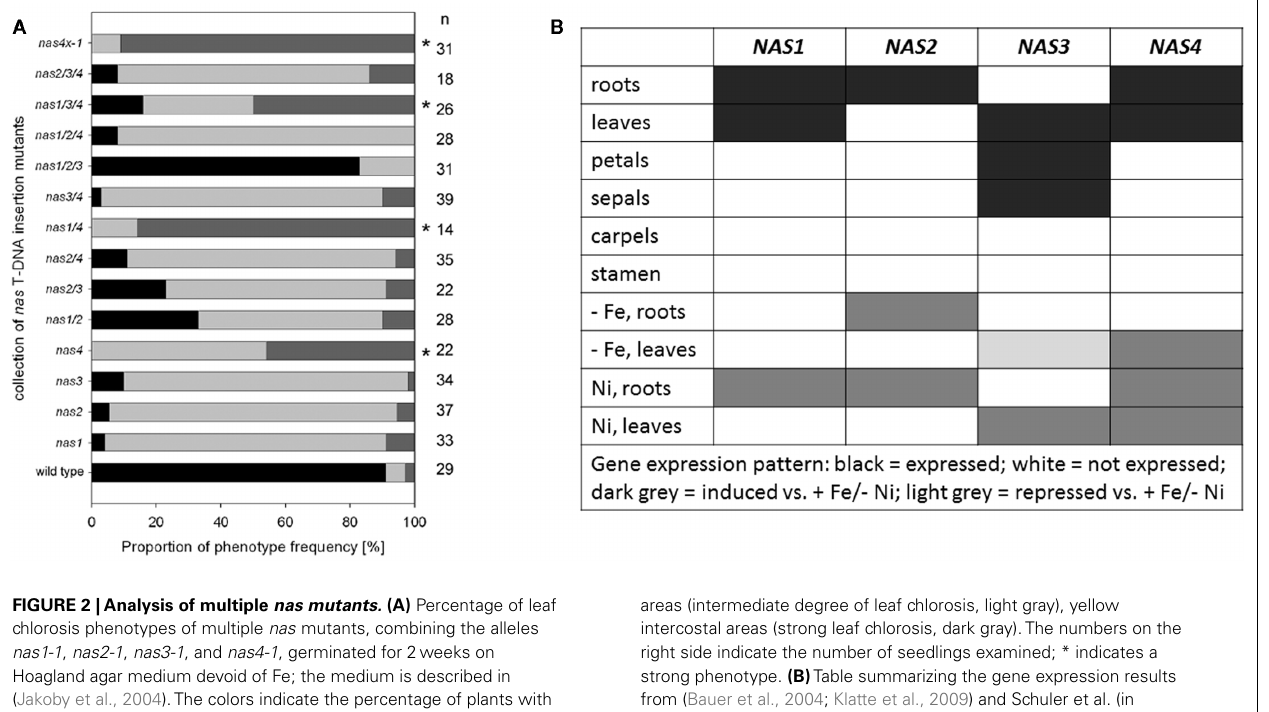
FIGURE 2 |Analysis of multiple nas mutants. (A) Percentage of leaf chlorosis phenotypes of multiple nas mutants, combining the alleles nas1-1 , nas2-1 , nas3-1 , and nas4-1 , germinated for 2weeks on Hoagland agar medium devoid of Fe; the medium is described in (Jakoby et al., 2004).The colors indicate the percentage of plants with light green leaves (weak leaf chlorosis, black), light green intercostal